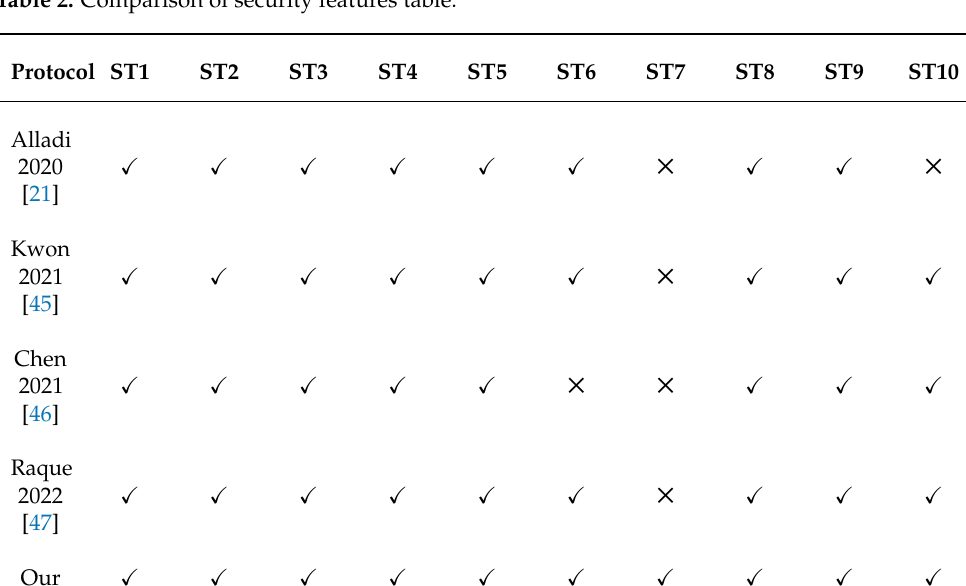
Figure 4. Average time taken by various operations. Table 2. Comparison of security features